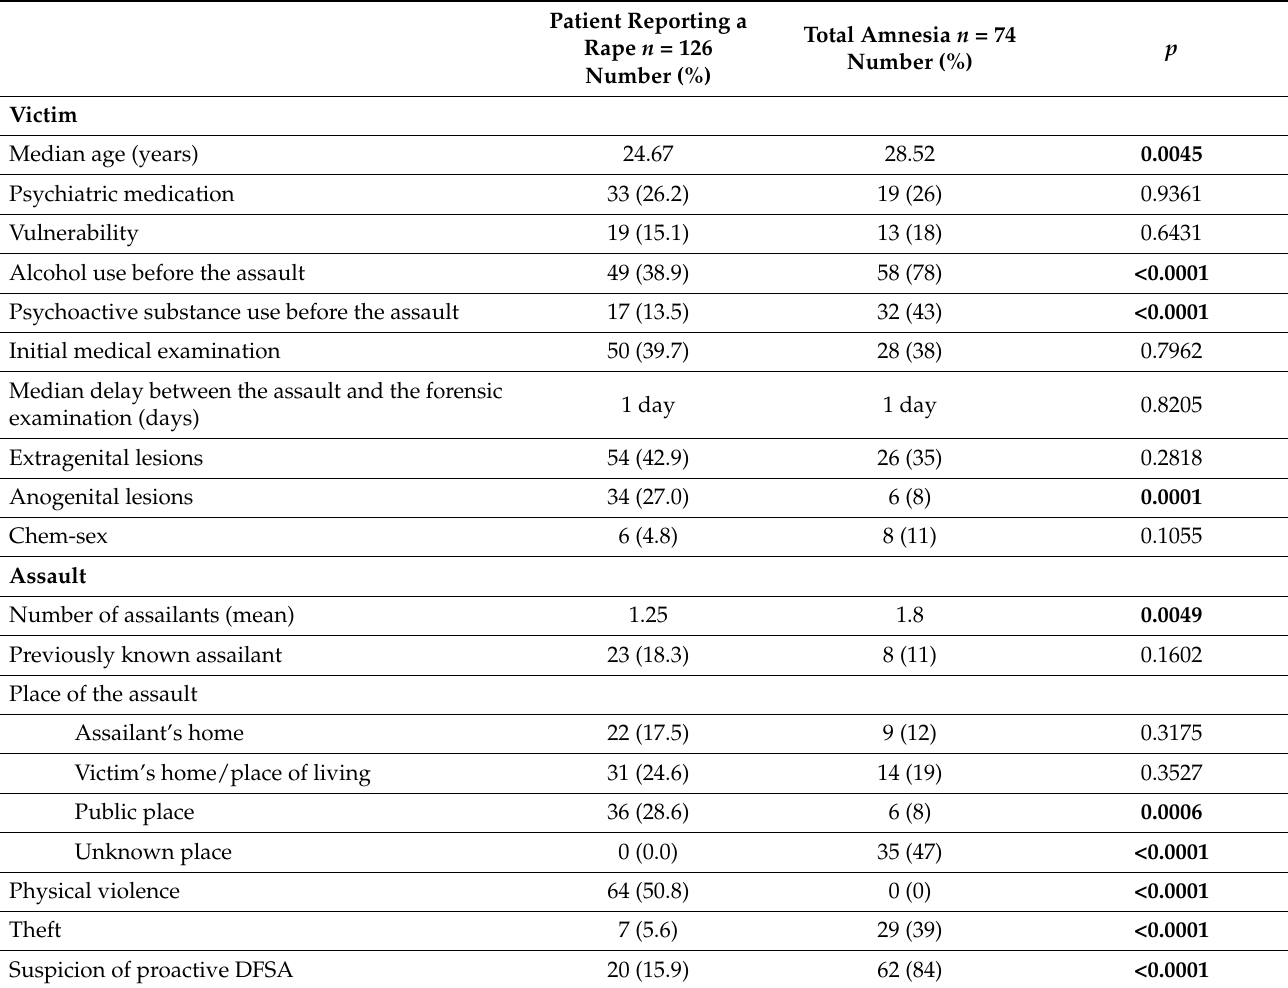
Table 3. Characteristics of the victim and the assault according to the victim’s memory of the assault. The bold number were for all p < 0.005